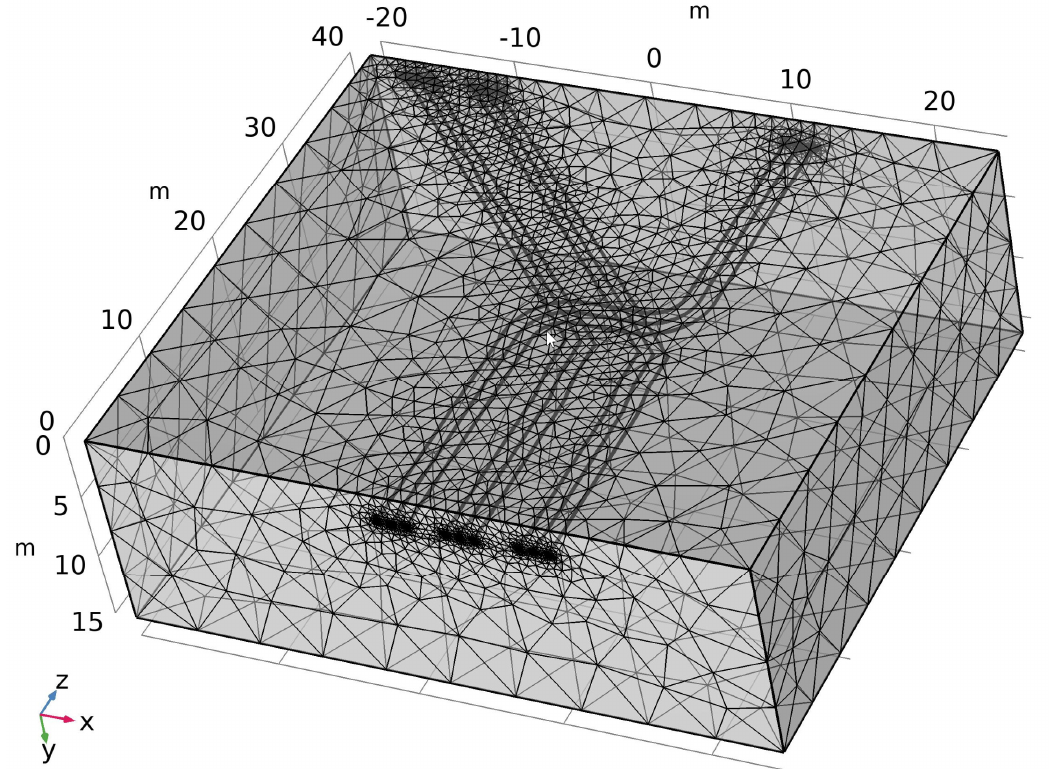
Figure 14. Mesh for the cable arrangement in Figure 12.